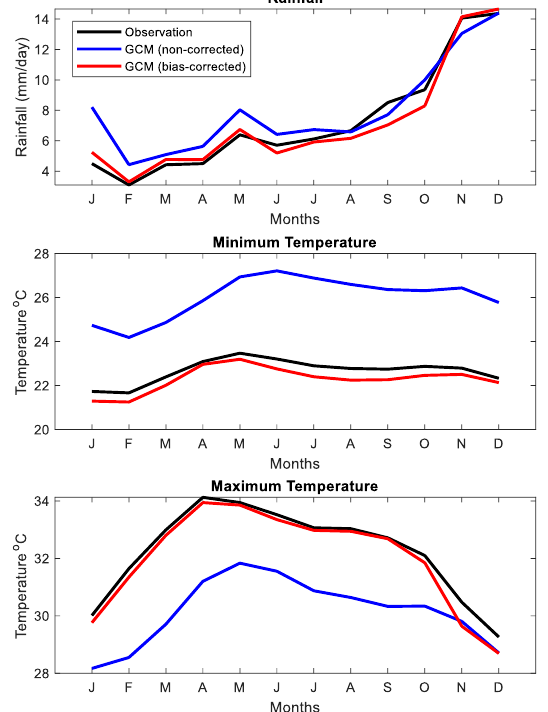
Figure 3. The comparison of catchment average daily rainfall, maximum temperature and minimum temperature climatology of the raw GCM simulation and bias-corrected GCM simulation against the observed values from 1981 – 2009. Table 1. The mean absolute error comparing the observation data and raw GLENS simulation and bias-corrected GLENS simulation.